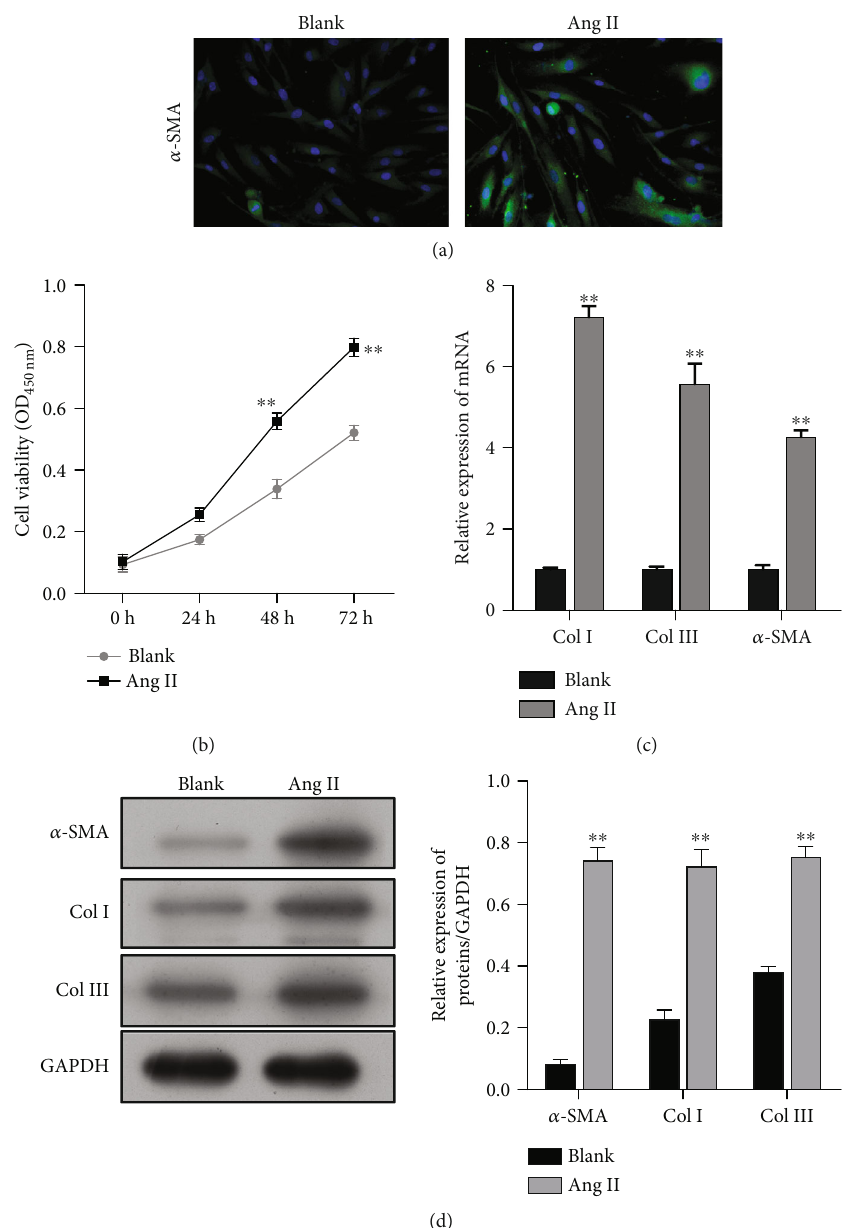
Figure 1: Preparation of activated HSCs induced by Ang II. (a) Immuno fl uorescence images of α -SMA in LX-2 cells with or without Ang II treatment. (b) The viability of LX-2 cells from the Ang II and blank groups was determined by the CCK-8 assay. (c) Quantitative real-time PCR and (d) western blotting were performed to measure the levels of α -SMA, Col I, and Col III expression in LX-2 cells with or without Ang II treatment. Data are expressed as the mean value ± standard deviation (SD). ∗∗ p < 0 : 01 , compared with the blank